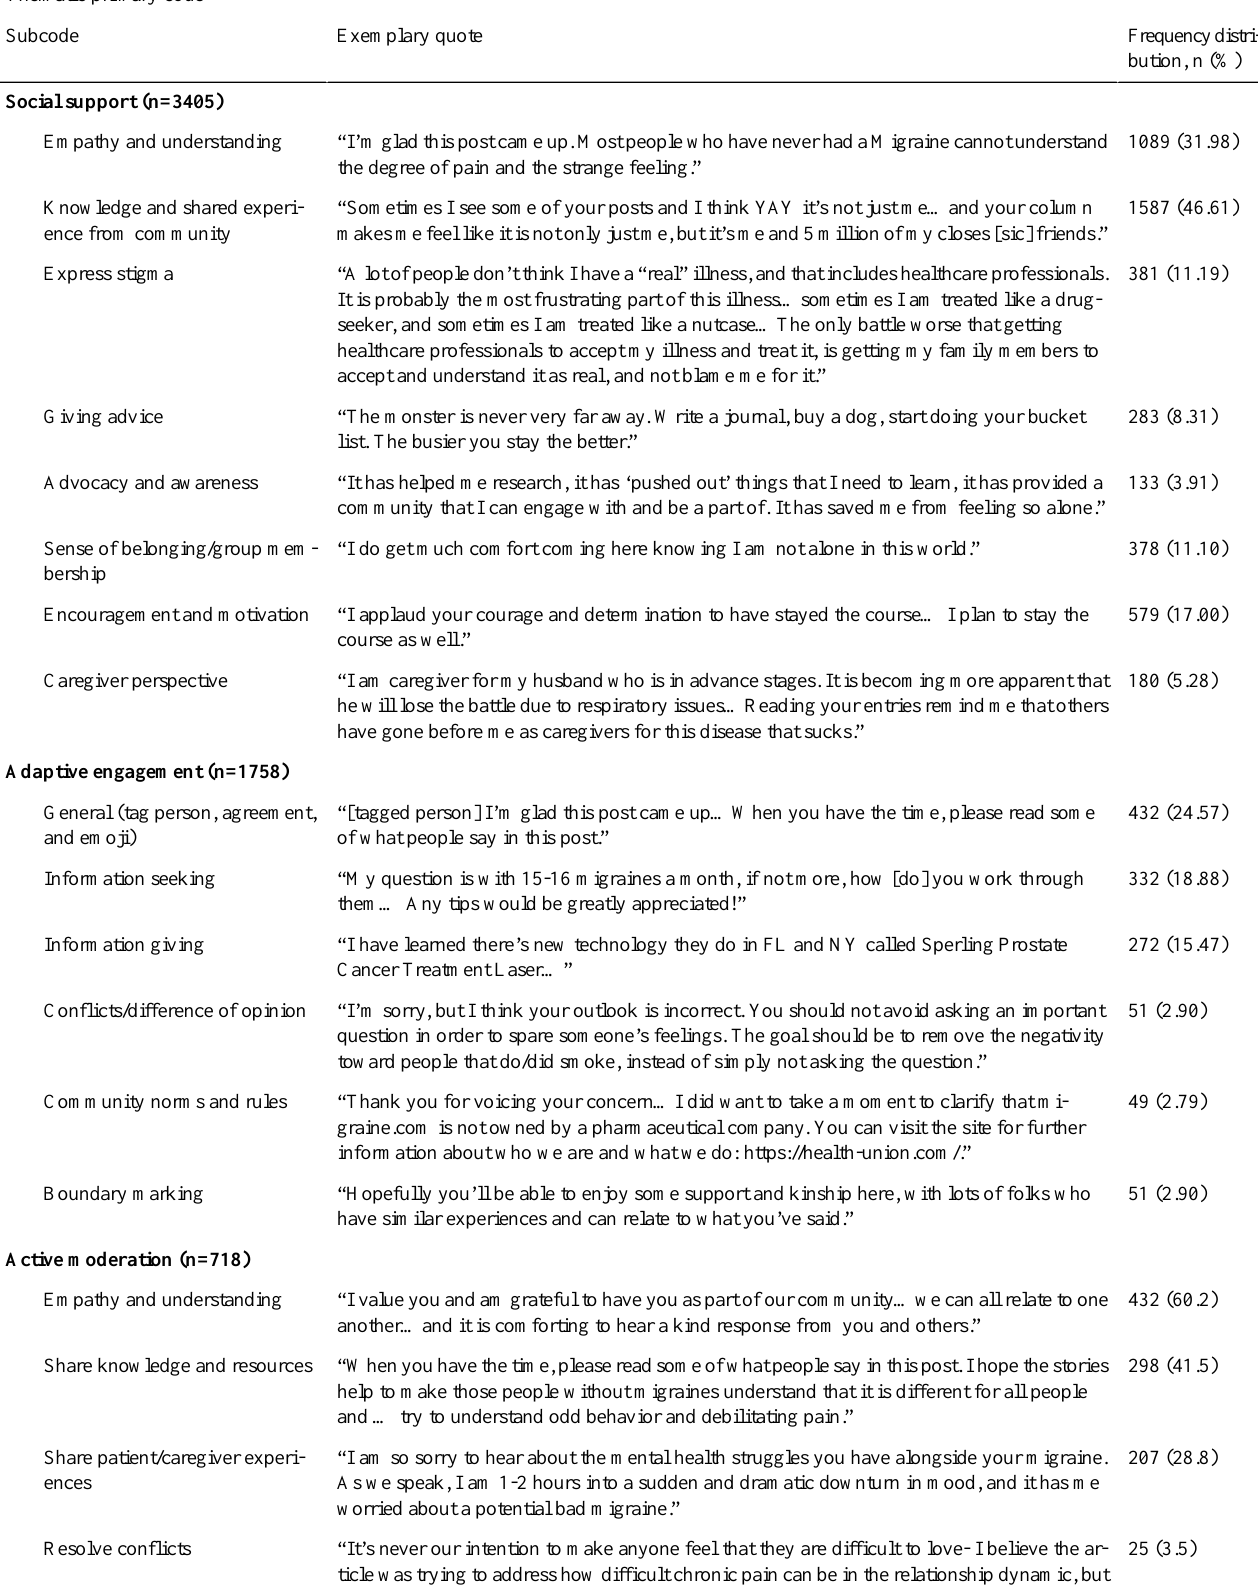
Table 2. Exemplary quotes demonstrating qualitative themes and their frequency distribution. Thematic primary code